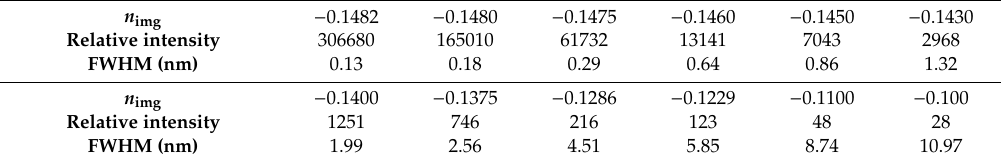
Table 1. Relative intensity and FWHM for DC = 40% at di ff erent gain values ( n img ).